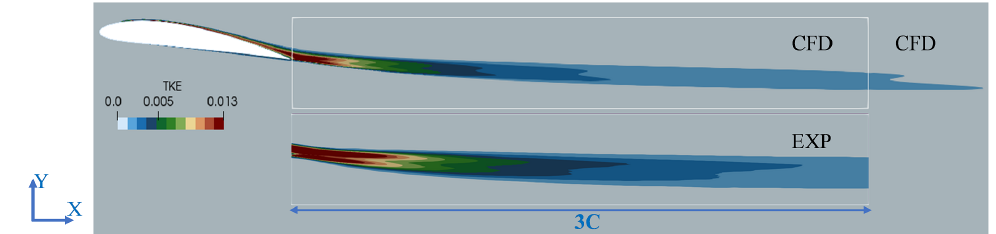
Figure 10. Contour plot of TKE at AOA = 8 ◦ : CFD (RANS) vs. EXP (HW). The data is scaled with U 2 ∞